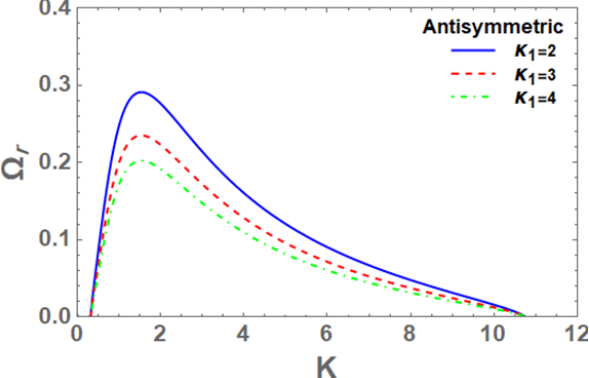
Figure 7. Variation of non-dimensional growth rate Ω r with non-dimensional wave number K for various medium permeability values κ 1 , when We = 1000; Oh = 0.1; ρ = 0.01; n = 1; v = 0.2; κ 1 = 2; ˜ (cid:101) l = 0.3; ˜ (cid:101) g = 0.1; E = 3; U = 1.5; V (cid:48) = 0.1, for axisymmetric disturbance